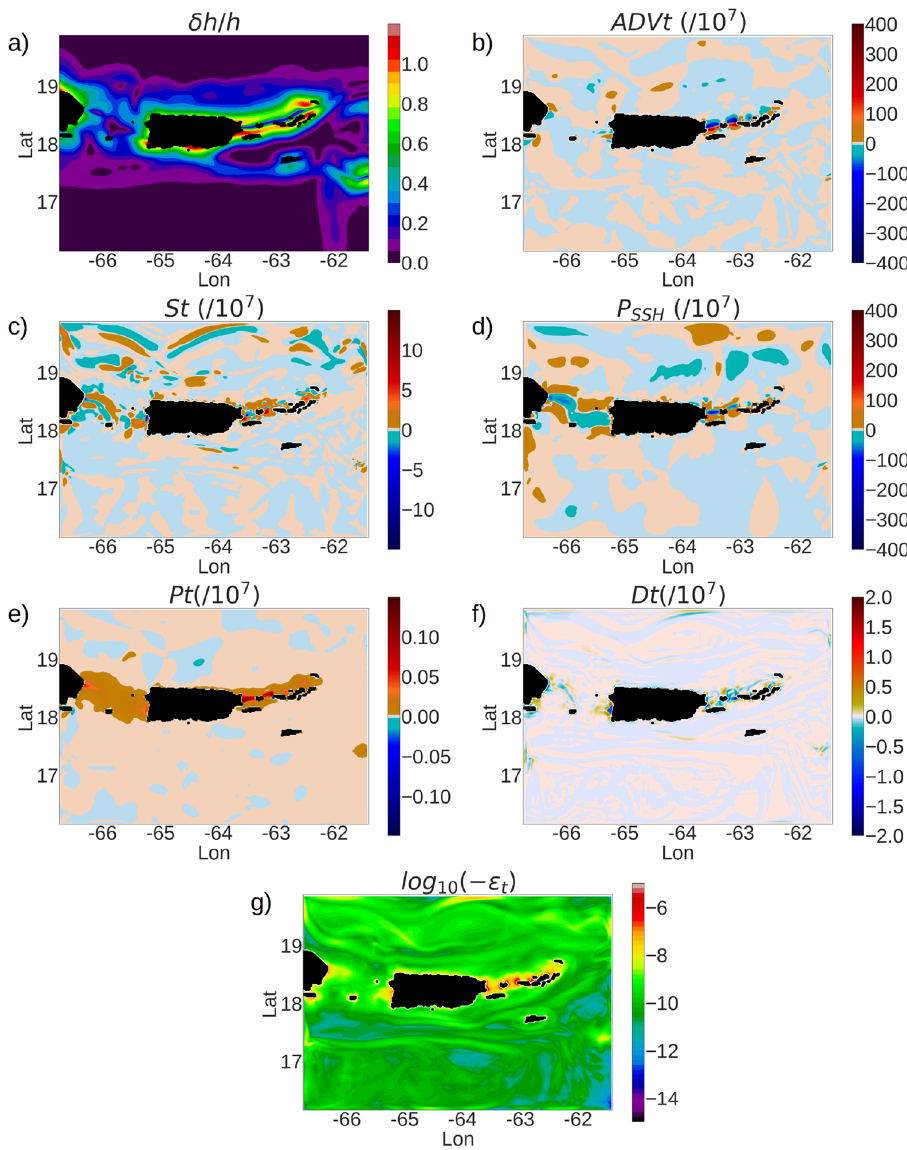
Figure 7. Snapshots of the different terms in the depth-averaged E BTK prognostic Eq. B8 (Online Appendix 7). ( a ) δ h / h , ( b ) ADVt , ( c ) St , ( d ) P SSH , ( e ) Pt , ( f ) Dt , ( g ) ǫ t . All components are averaged over 1 month in order to minimize the mesoscale and submesoscale perturbations. The color ranges are different for the individual plots in order to show the flow patterns